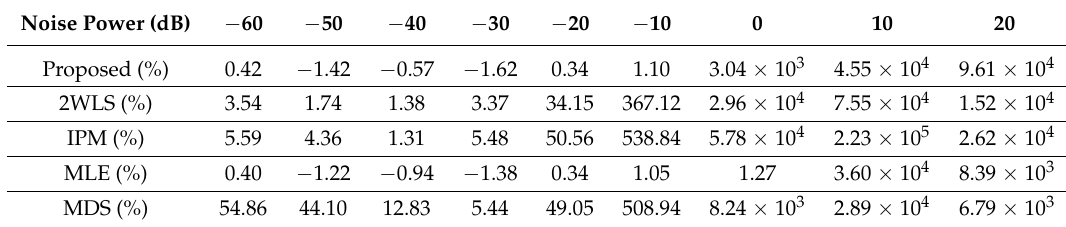
Figure 7. Bias performance as error level increasing (near source, 4 sensors). Table 2. MSE increasing percentage (near